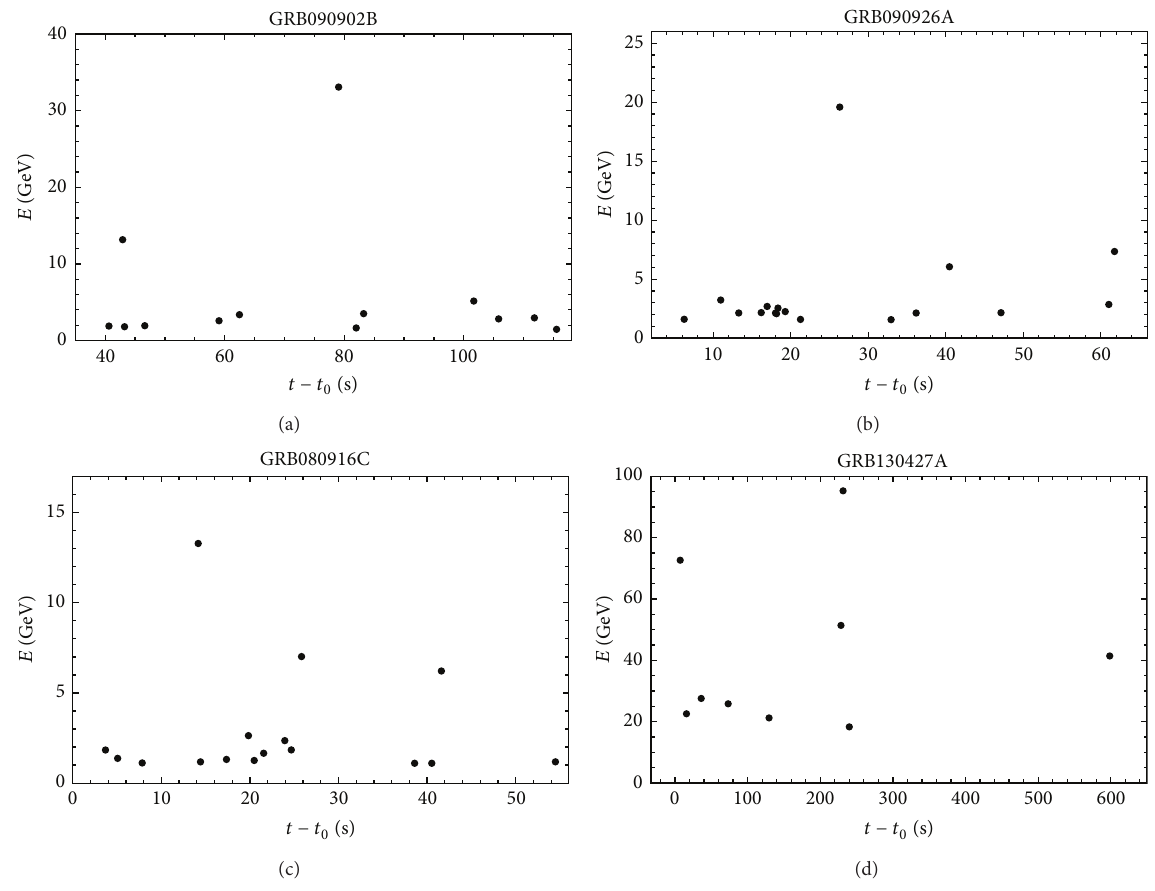
Figure 15: Here (d) shows data points with energy greater than 15 GeV, which illustrate the structure of our hard minibursts: a miniburst occurring between 230 and 260 seconds after trigger is preceded by a relatively long time interval ( ≃ 100 seconds) of “high-energy silence,” and farther back in time one finds rather frequent detections of high-energy photons. Even for GRB130427A (observed in “high resolution”) the hard minibursts are composed of only a few photons, characterized by soft spectral lags, with in particular the highest-energy photon in the miniburst observed as the first photon in the miniburst. When we looked for supporting evidence for these features within the three brightest pre-GRB130427A Fermi-LAT long GRBs (other three panels in this figure (a), (b), and (c)) we did not find conclusive evidence of small bunches of photons governed by soft spectral lags. This also suggests that the size of the spectral lags within such hard minibursts gets bigger at higher redshift. We did find that in all three of these pre-GRB130427A Fermi-LAT long GRBs, when selecting only events above a suitably-high energy, the highest-energy photon was observed after a relatively large time interval of “high-energy silence,” as first photon of a phase of rather frequent detections of high-energy